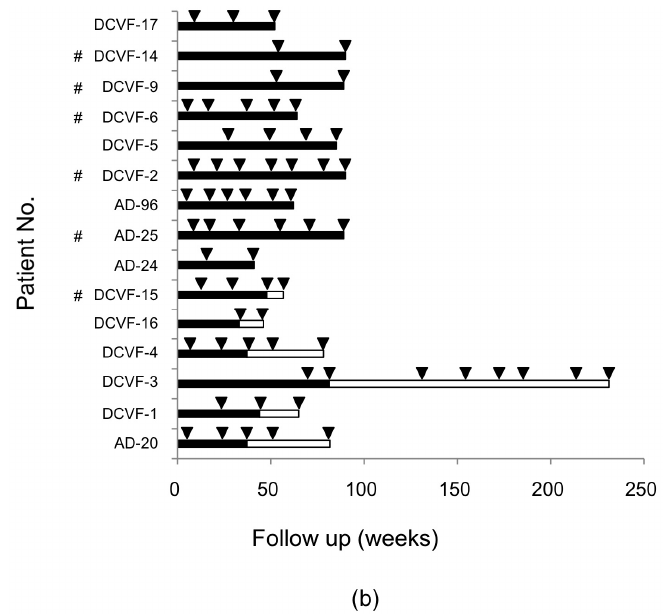
Figure 1. Alteration of D168 resistance-associated substitution (RAS) during follow-up after treatment failure. ( a ) Sixteen patients in simeprevir/pegylated-interferon/ribavirin (SMV/PEG-IFN/RBV) and ( b ) Fifteen patients in daclatasvir/asunaprevir (DCV/ASV) treatments were followed-up D168 RAS. Each line indicates an individual patient; the closed bar indicates a continuous predominant substitution and the open bar indicates a substitution reverting to the wild-type. Arrowheads indicate the point when RAS was determined. #: Patients with prior treatment of SMV/PEG-IFN/RBV.